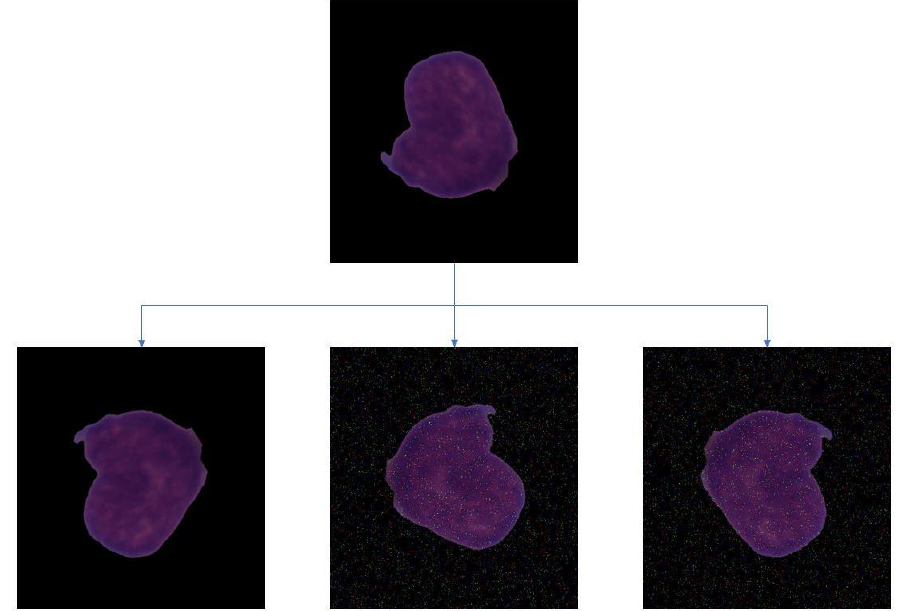
Figure 8. Original image of a blast cell and its augmented versions for the C_NMC_2019 dataset.